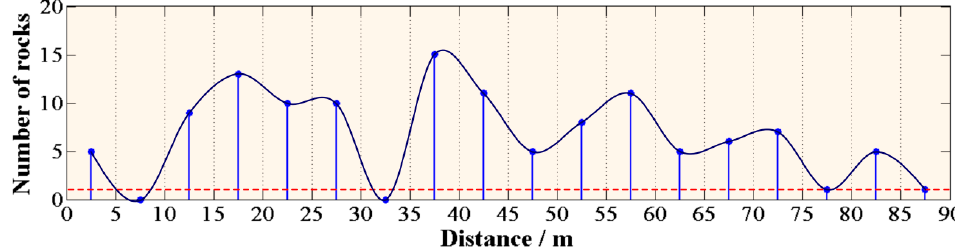
Figure 14. Scatterplot of the rock number and location at each 5 m.